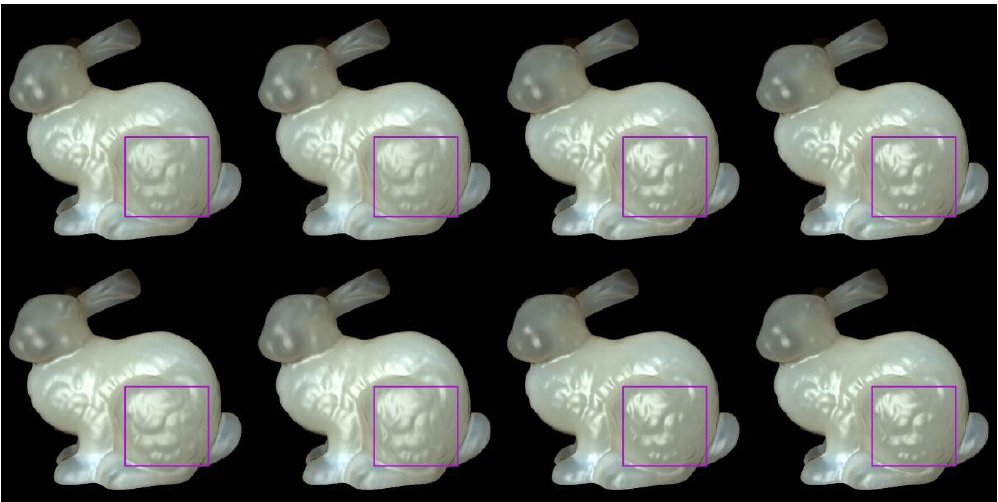
Figure 8. Comparison of highlight effects generated by our Lafortune-based method (first row) and the method based on the traditional Lafortune model (second row) for chocolate milk (regular) material. From left to right, the n t , n b parameters are n t is 0.2, n b is 0.5; n t is 0.5, n b is 0.2; n t is − 0.2, n b is − 0.5; n t is − 0.5, n b is − 0.2.